Question: Write a single sentence explaining what this figure depicts.
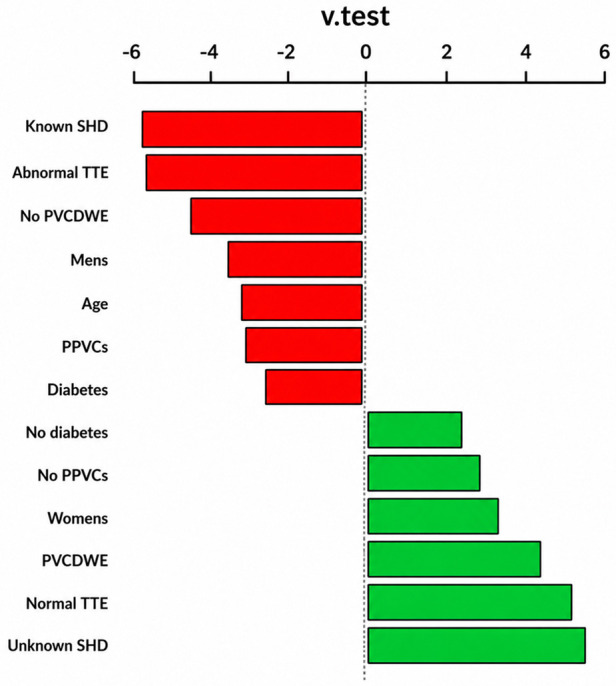
Answer: Bar chart representing covariates predictive of normal or abnormal CMR findings. Green bars represent the variables predicting normal CMR findings, and red bars represent the variables predicting abnormal CMR findings. The V-test represents the strength of the association between the various covariates and normal CMR findings. SHD, structural heart disease; TTE, transthoracic echocardiography; PVCDWE, premature ventricular contractions decreasing with exercise; PPVC, pleomorphic premature ventricular contractions.